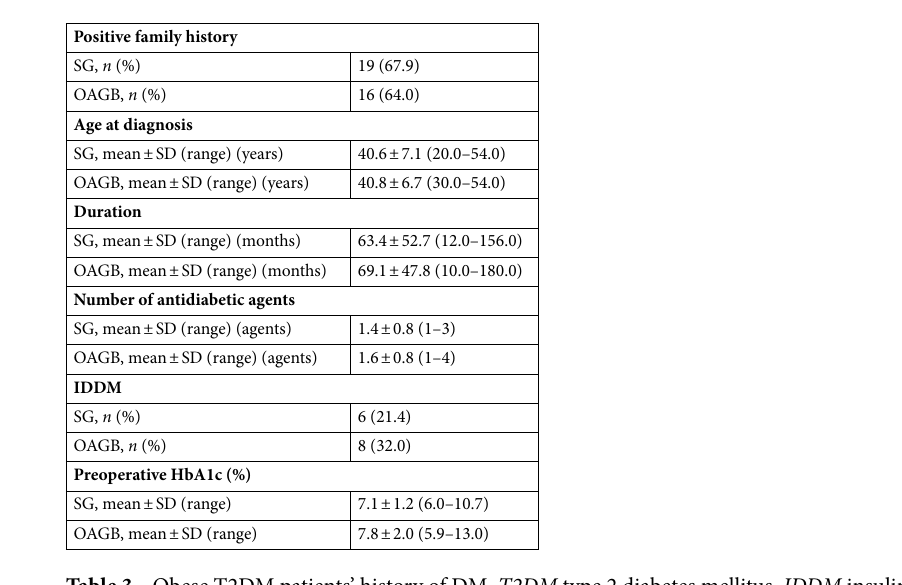
Table 3. Obese T2DM patients’ history of DM. T2DM type 2 diabetes mellitus, IDDM insulin dependent diabetes mellitus, HbA1c (%) glycated haemohemoglobin, SG sleeve gastrectomy, OAGB one anastomosis gastric bypass, SD standard